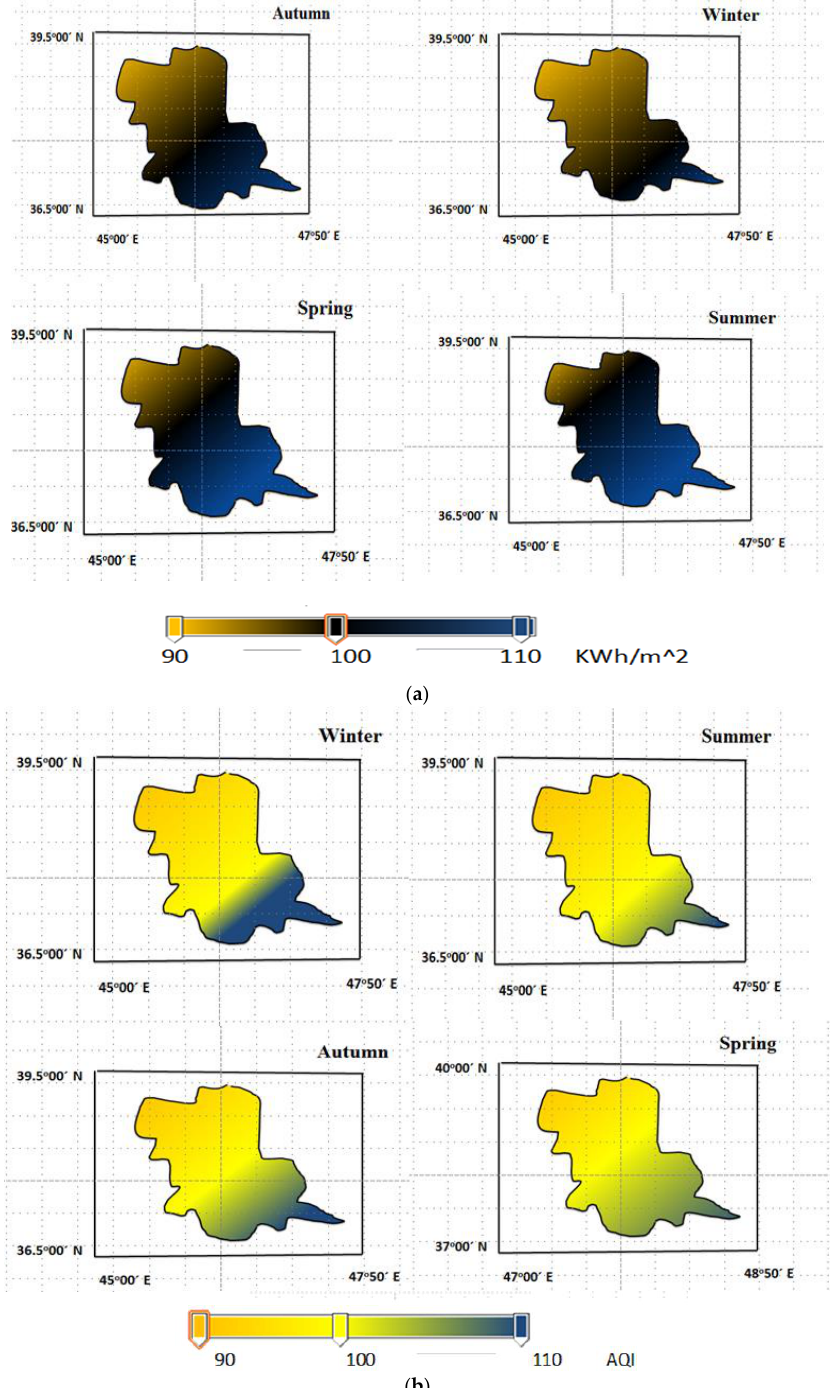
Figure 9. ( a ) The AQI variation for di ff erent provinces based on obtaining zoning map, ( b ) the zoning map for the